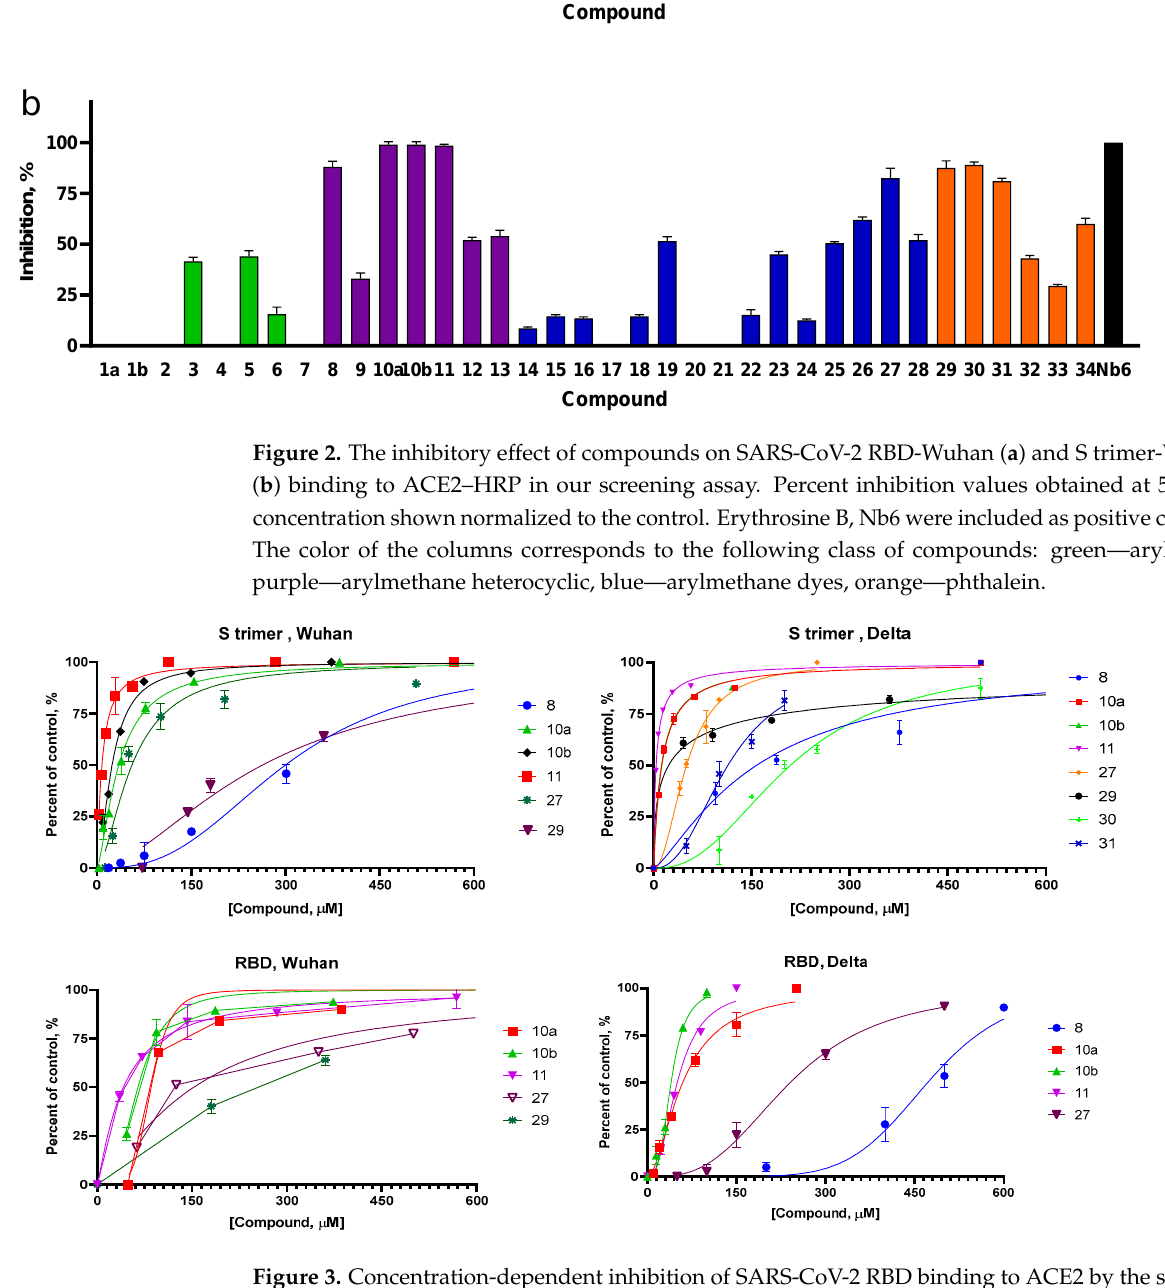
Figure 3. Concentration-dependent inhibition of SARS-CoV-2 RBD binding to ACE2 by the selected compounds. Concentration–response curves obtained in the ELISA competitive assay with RBD coated on the plate and ACE2–HRP added and the amount bound in the presence of increasing concentrations of the test compounds detected. Data (mean ± SD for two experiments in duplicates) were normalized and fitted with standard inhibition curves; obtained IC 50 values are shown at Table 5.